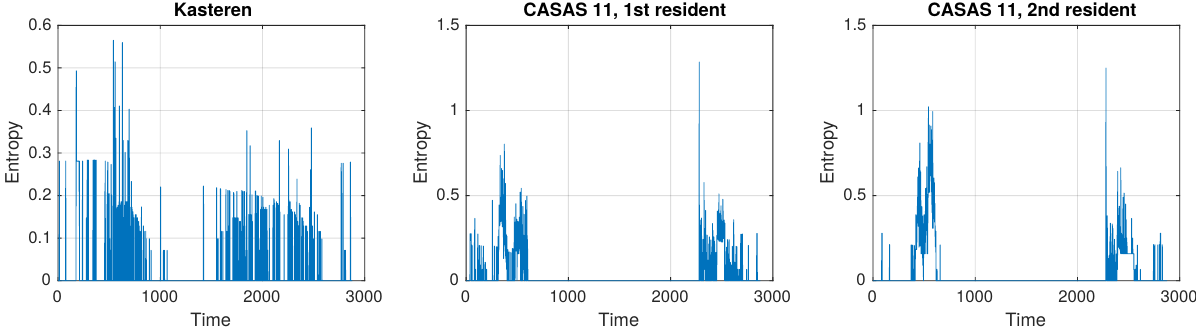
Figure 4. The conditional entropy of activities at different times of the day for the Kasteren dataset, the first resident of the CASAS 11 dataset, and the second resident of the CASAS